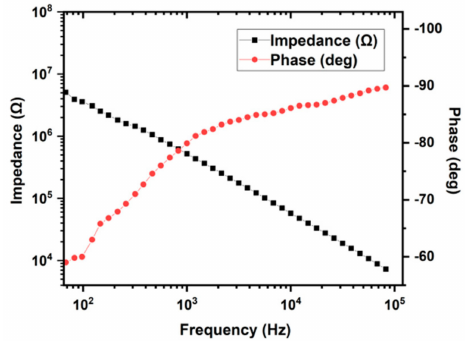
Figure 7. A typical electrochemical impedance spectroscopy of a Pd electrode.